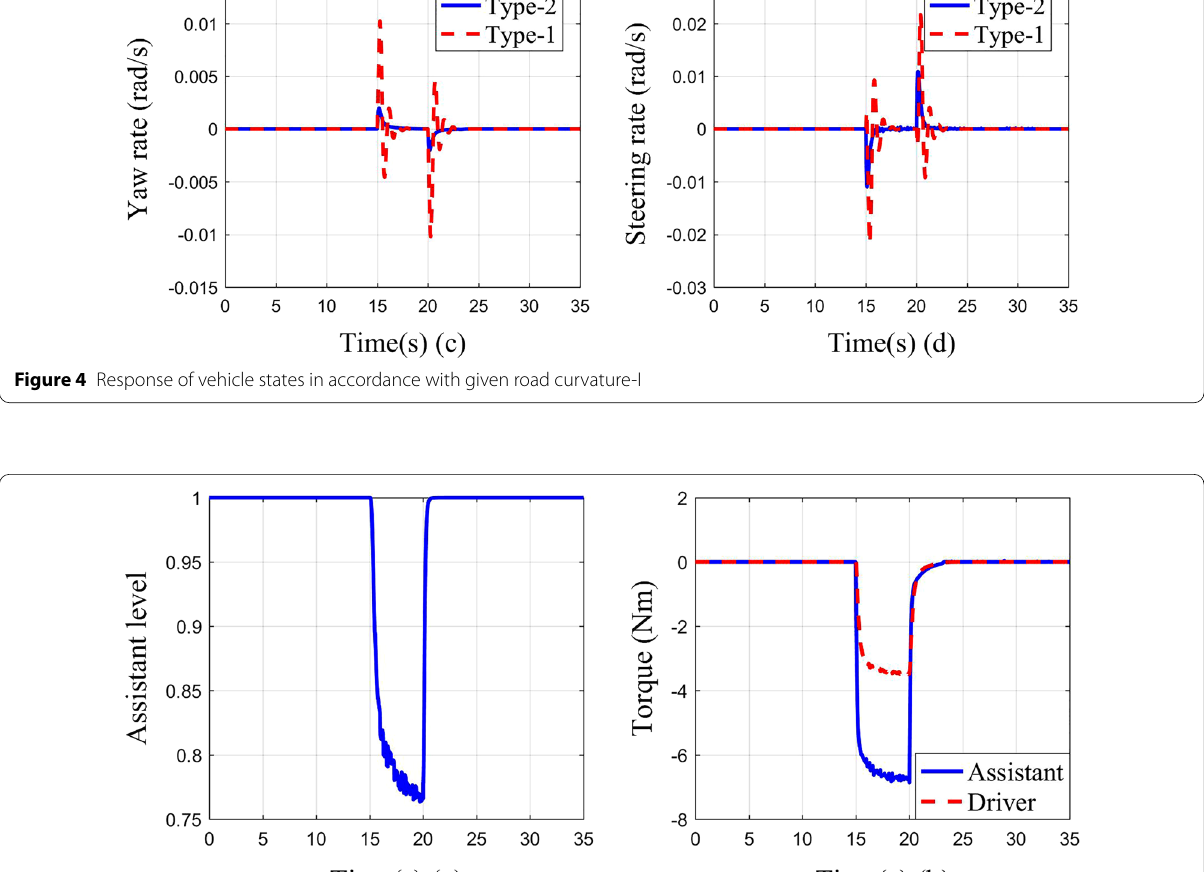
ured vehicle speed in the simulation structure. The vehicle speed containing error is sent to the type-2